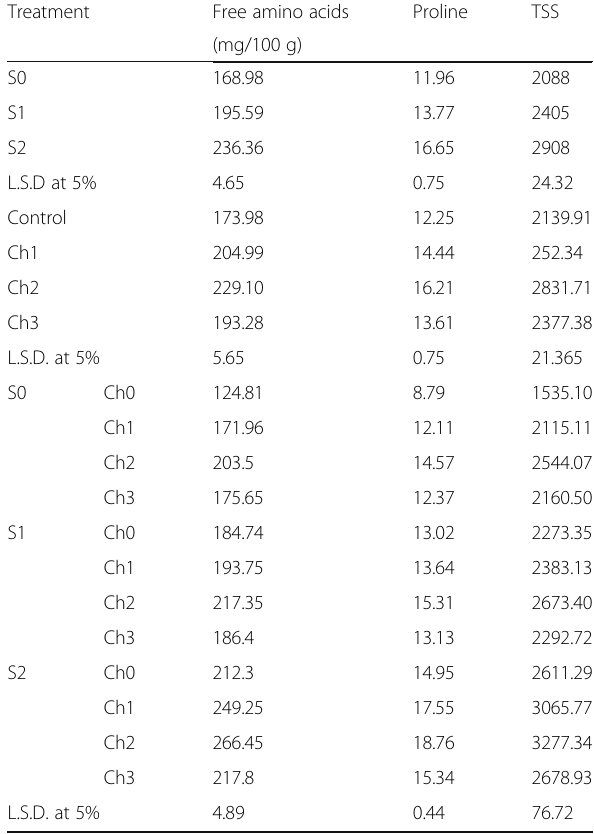
Table 3 Effect of salt stress, chitosan concentration, and their interaction on osmoprotectants (free amino acids, proline, and TSS) contents of sunflower plant